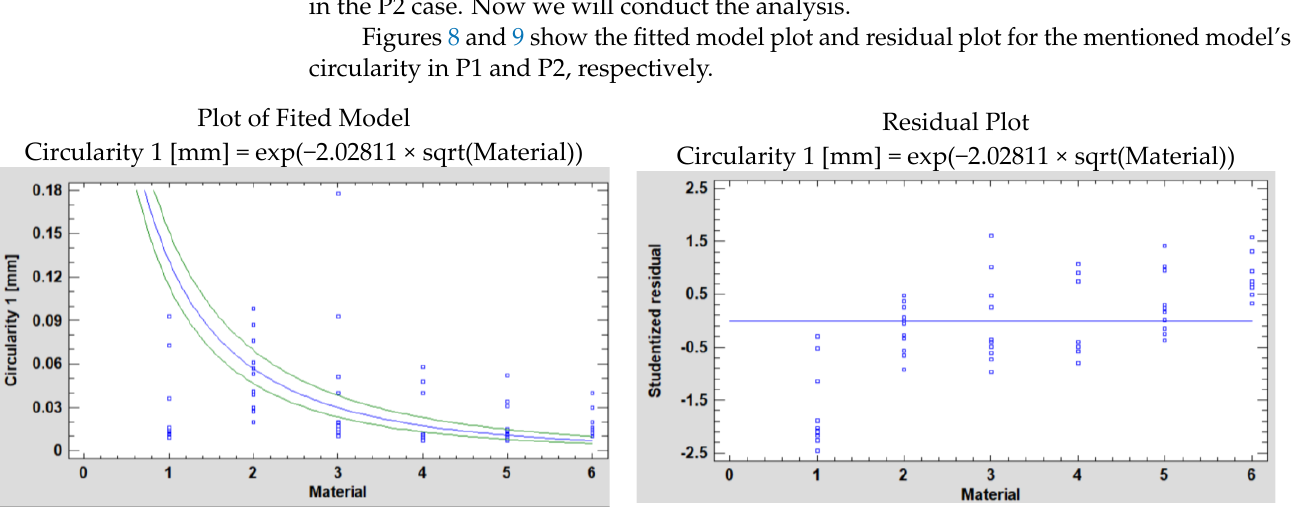
Figure 8. Plot of fitted model and residual plot for circularity 1 using the Logarithmic-Y square root-X model of the simple regression.